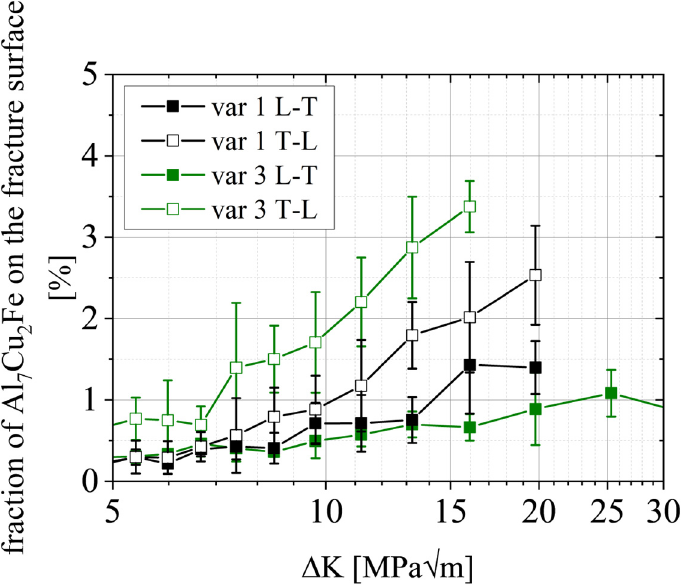
Figure 14. Area fraction of Al 7 Cu 2 Fe-type particles on the fracture surface as a function of ∆ K for forging variants 1 and 3, respectively.